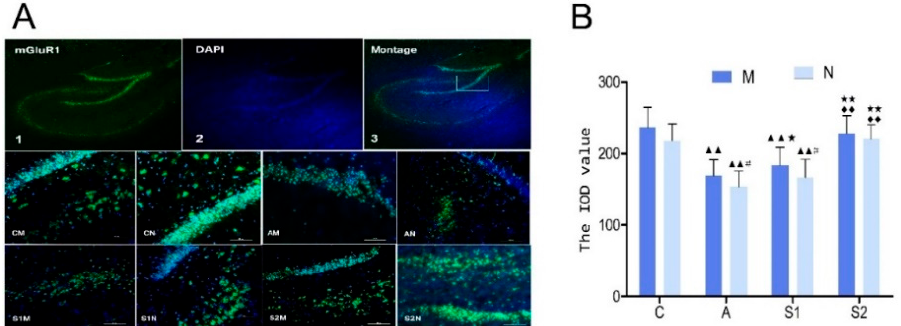
Figure 5. ( A ): Representative images of metabotropic glutamate receptor 1 (mGluR1) in the rat hippocampal dentate gyrus (DG) region. The expression levels of mGluR1 were assessed by immunofluorescent staining and the integral optical density (IOD) values were quantified in the images captured by laser confocal scanning microscopy (× 200 magnification; the length scale bar indicates 100 µm). The red fluorescence was mGluR1 of FITC, blue fluorescence was the nuclei of DAPI-labeled hippocampal neurons, along with the superimposed image. ( B ): Changes of mGluR1 IOD value in rat hippocampus DG region, which were quantified with image vector analysis. Data are presented as Mean ± SD ( n = 10/group). The in-graph symbols indicate: ▲▲ p < 0.01 versus Group C ; * p < 0.05 or ** p < 0.01 versus Group A ; ◆◆ p < 0.01 versus Group S1 ; # p < 0.05 versus Group M .